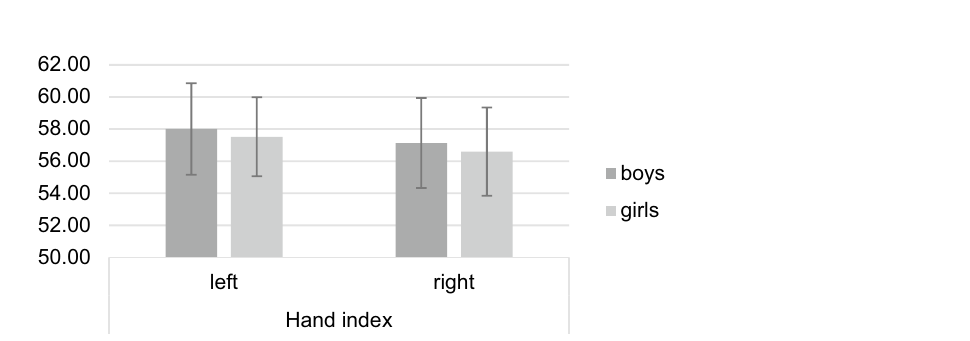
Figure 6. Means and standard deviations in right, left, and averaged hand index separately for boys and